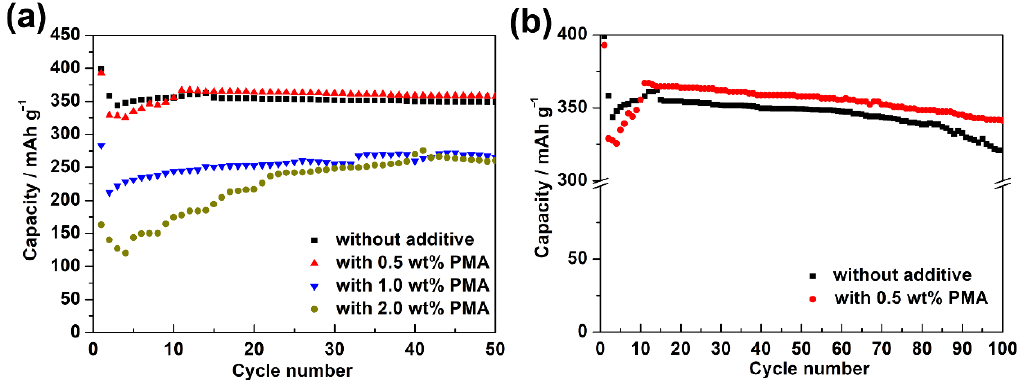
Figure 3. ( a ) Cycling performance of the MCMB electrodes charged and discharged in the base electrolyte containing various PMA concentrations at 0.1C for 50 cycles at room temperature. ( b ) The comparison of long-term cycling performance between the MCMB anodes tested in PMA-free and 0.5 wt% PMA-containing electrolytes at 0.1 C for 100 cycles at room temperature.